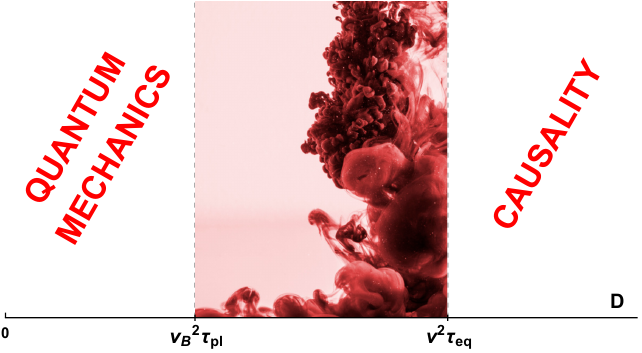
Figure 1: The lower and upper bounds on the diffusion constant D . Here, v for the butterfly velocity, v is the lightcone speed, τ equilibration